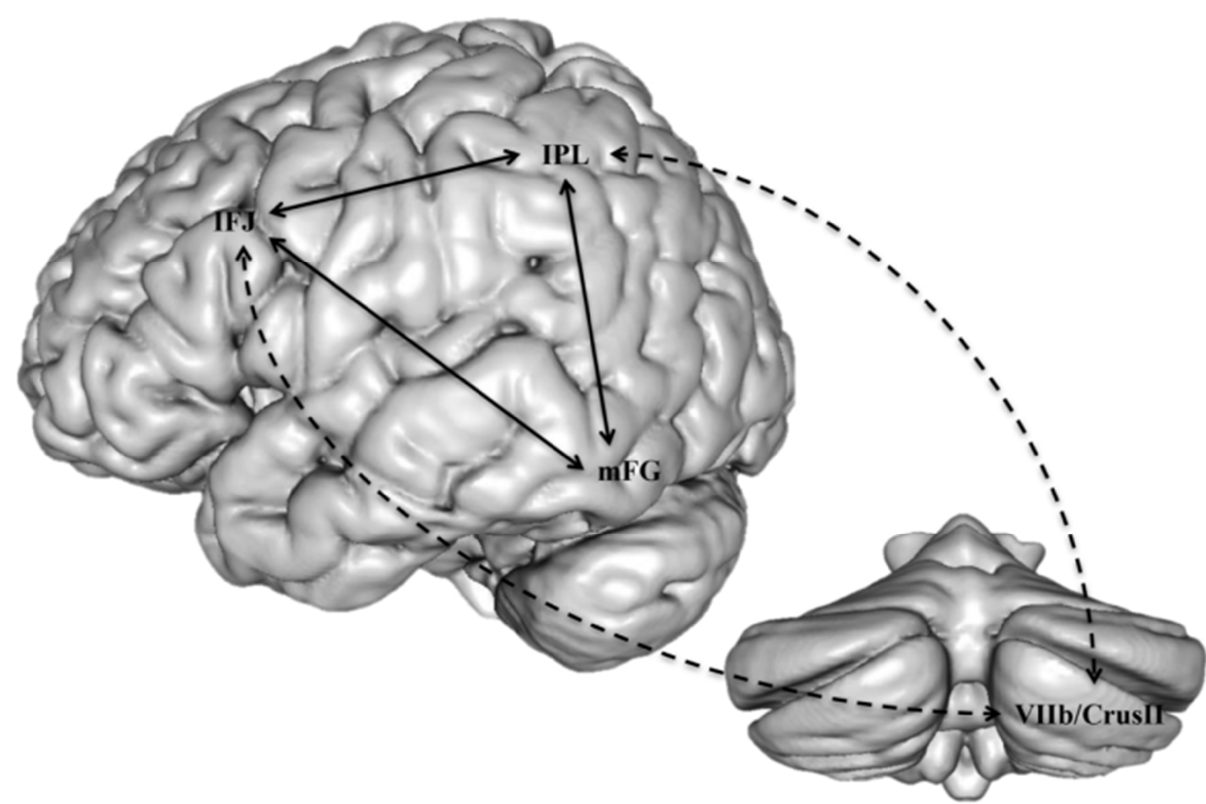
Figure 6. A presumed substrate of the modulatory role of the cerebellum on dorsal phonological processes in reading, indirectly affecting orthographic processes in the inferior temporal region (from [69]). IFJ: inferior frontal junction; IPL: inferior parietal lobule; mFG: mid-fusiform gyrus.